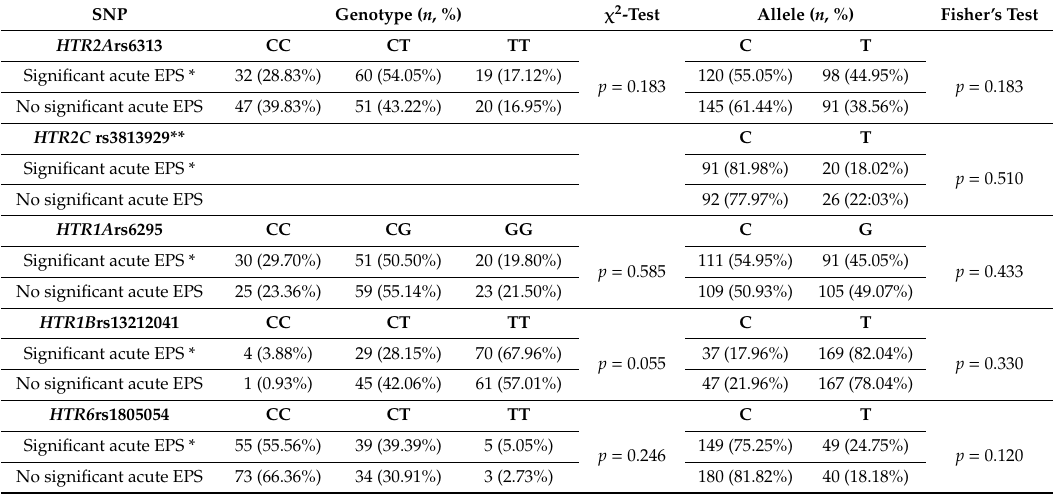
Table 3. Genotype and allele frequencies of 5-HT receptor gene polymorphisms in schizophrenia patients, subdivided according to the development of significant acute EPS following haloperidol therapy.